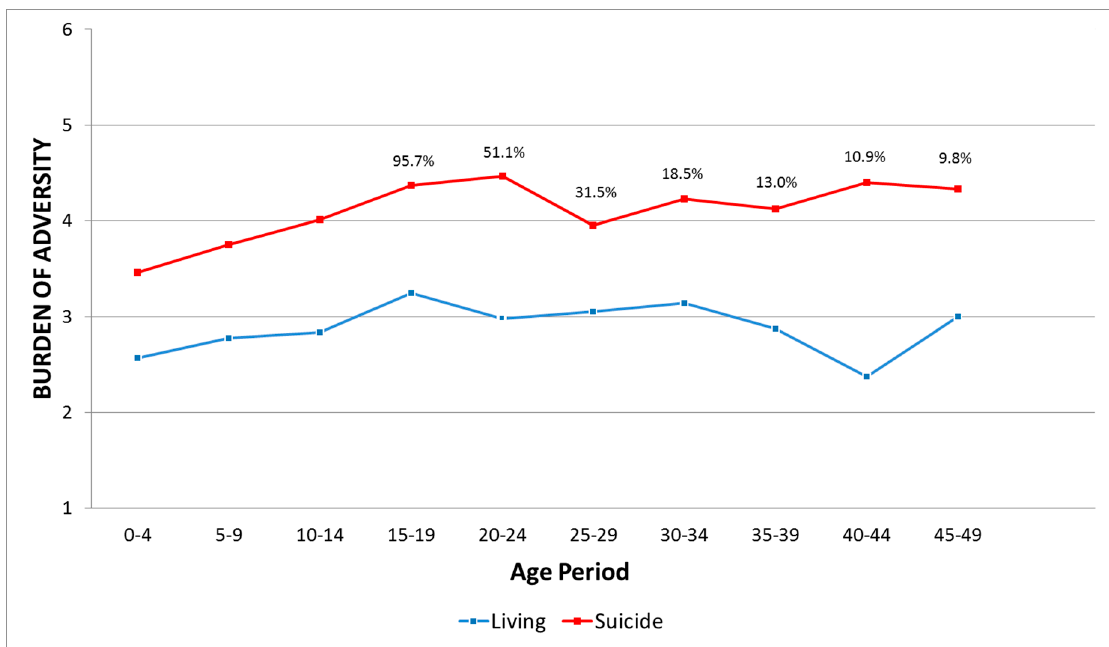
Figure 1. Trajectories of control-group and suicide cases. The % corresponds to the proportion of serving individuals on entry of the age period for the suicide group. Table 1. Trajectory parameters.